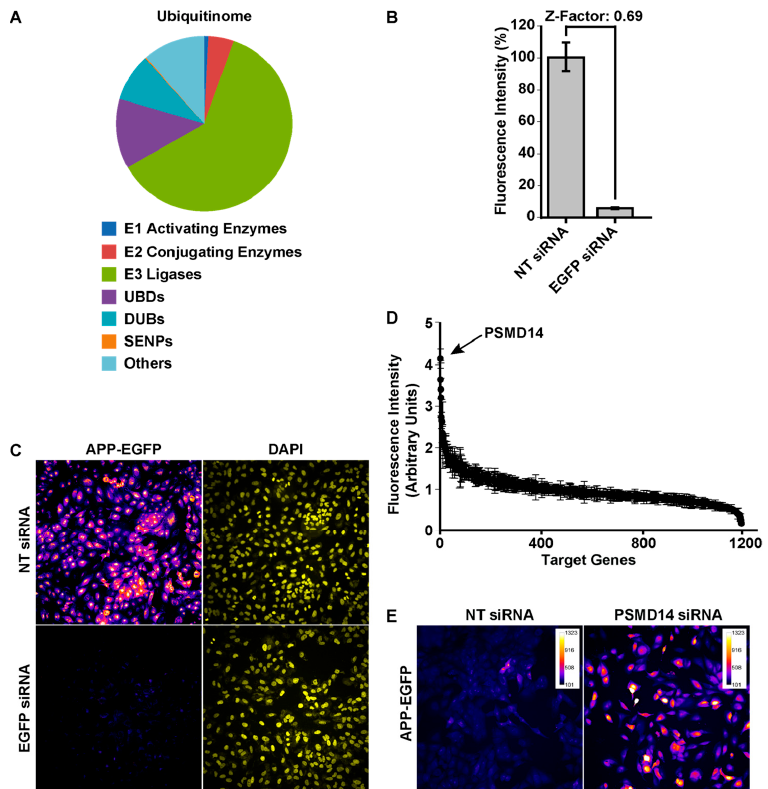
Figure 1. High-content siRNA screening assay revealed PSMD14 as a novel regulator of amyloid precursor protein (APP) levels. ( A ) Graphical distribution of the targets evaluated in the primary high content siRNA screening using the siRNA "ubiquitinome" library in H4 cells. ( B ) Quantification of the total fluorescence intensity of reporter APP-EGFP cells transfected for 72 h with NT siRNA and EGFP siRNA. Bars represent the mean ± SD with a statistical Z factor = 0.69. ( C ) High content images (20×) captured in reporter APP-EGFP cells transfected for 72 h with non-target (NT) siRNA and EGFP siRNA. ( D ) Graphical representation of total fluorescence intensity of all 1187 genes analyzed in primary siRNA screening with the reporter APP-EGFP cells. PSMD14 appears indicated as the top hit. ( E ) High content images (20×) in pseudo color of reporter APP-EGFP cells transfected for 72 h with siRNA SMARTpool targeted against PSMD14 (PSMD14 siRNA) in comparison to cells transfected with NT siRNA. The fluorescence intensity in these images was reduced to avoid saturation with the PSMD14 siRNA. Scale Bar of the images indicates the scale of fluorescence